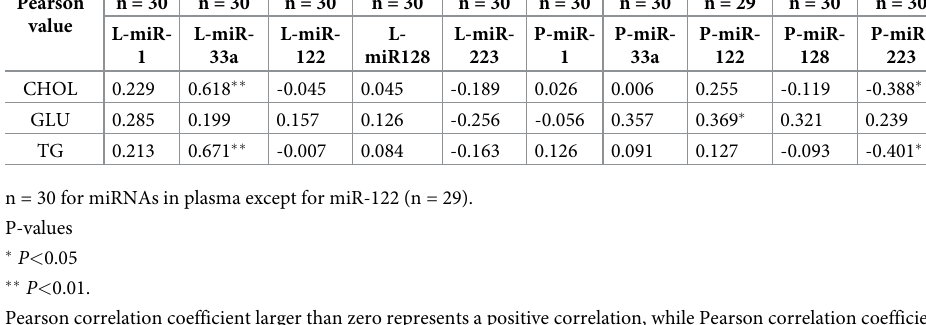
Pearson correlation coefficient larger than zero represents a positive correlation, while Pearson correlation coefficient less than zero represents a negative correlation.